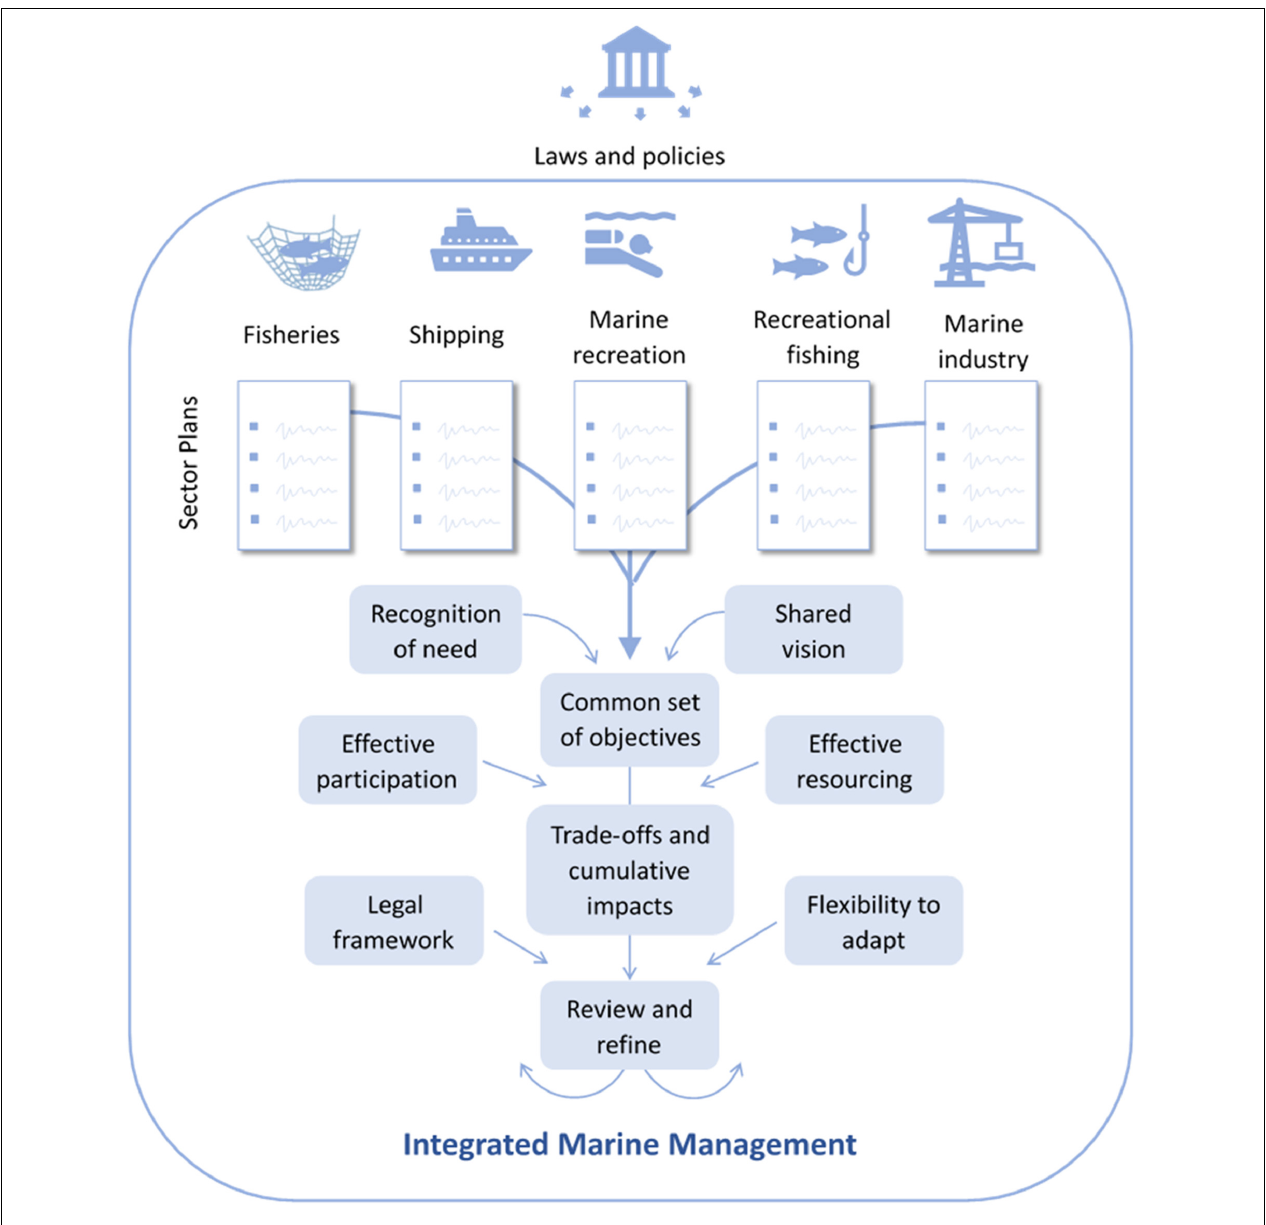
FIGURE 1 | Conceptual representation of a framework for Integrated Marine Management (IMM) demonstrating the nine key features of successful IMM [adapted from Stephenson et al.